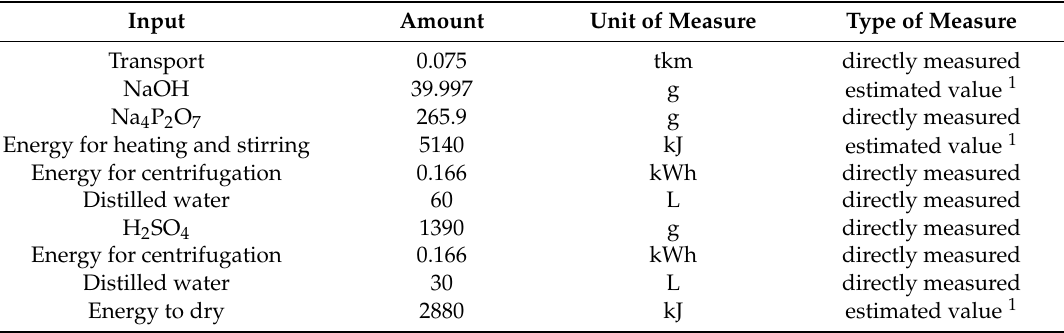
Table 9. Inventory for the extraction process of 1 kg of humic substances from the compost, according to [21,22].